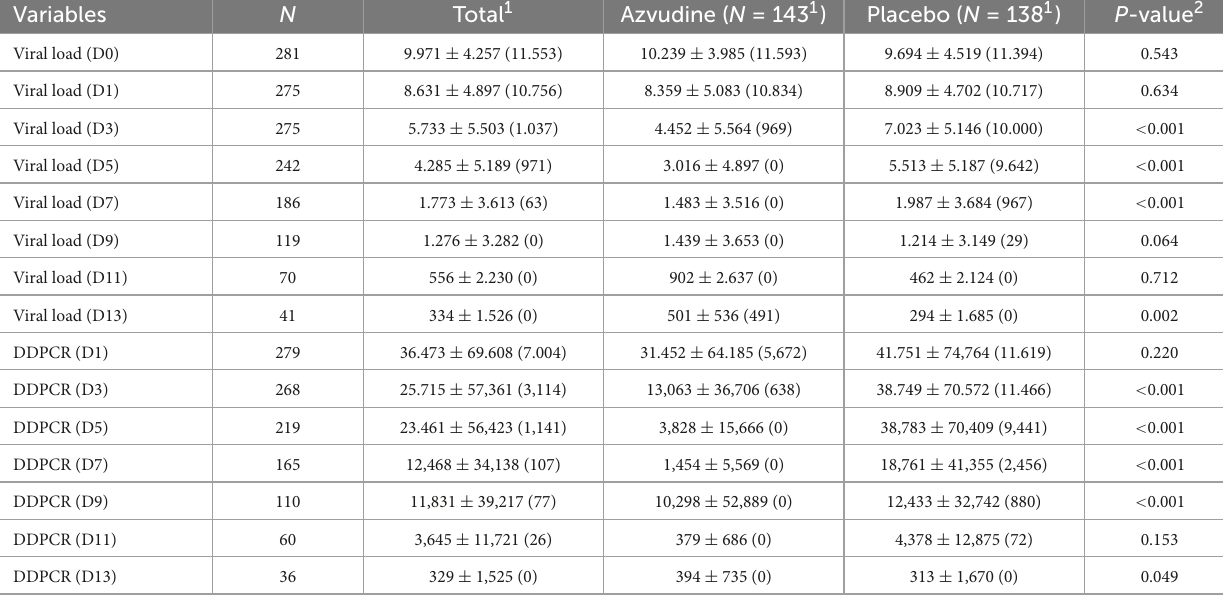
TABLE 2 Absolute viral load analysis by RT-PCR and DDPCR during the treatment